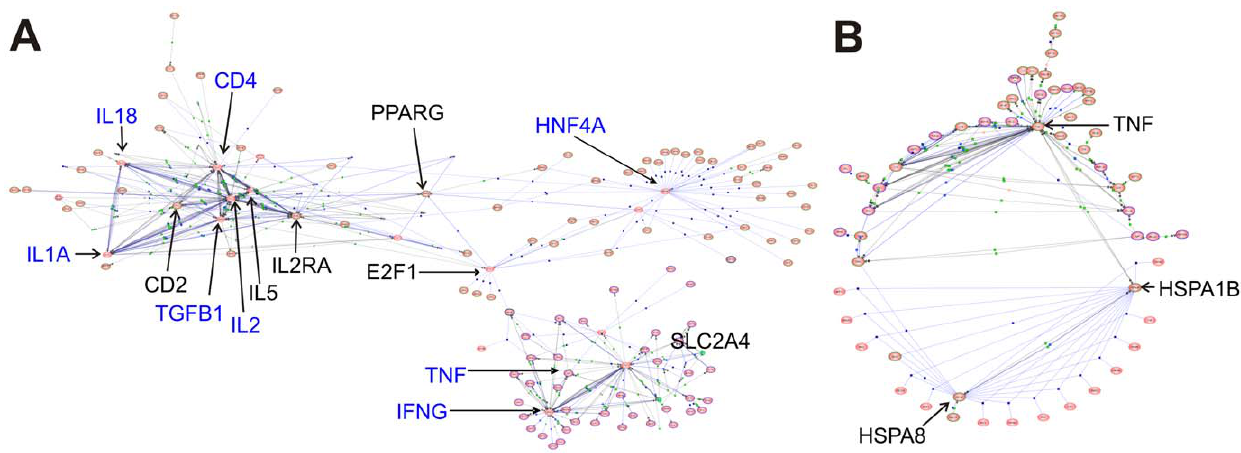
Figure 4. Interactome maps of differentially expressed mRNAs in livers of arsenic-exposed mice. A. PND1; B. PND70. Major hubs are annotated.